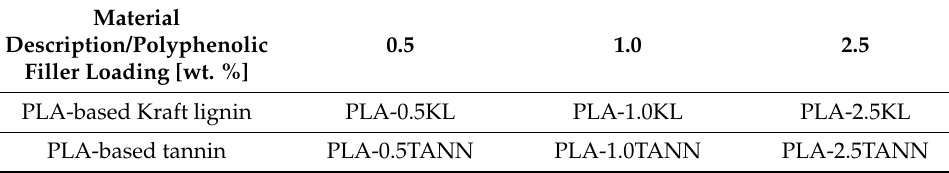
Table 1. Prepared PLA-KL and PLA-TANN composites.